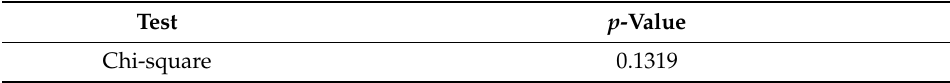
Table 4. Normality test for